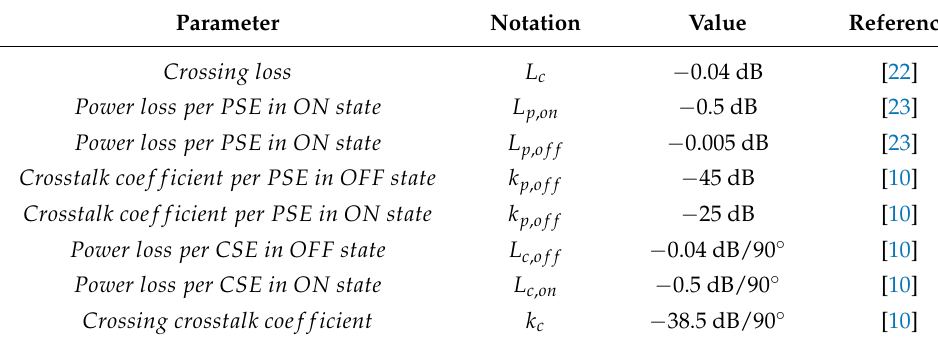
Figure 2. Basic 1 × 2 switching elements using microresonators. Table 1. Power loss factors of a basic optical